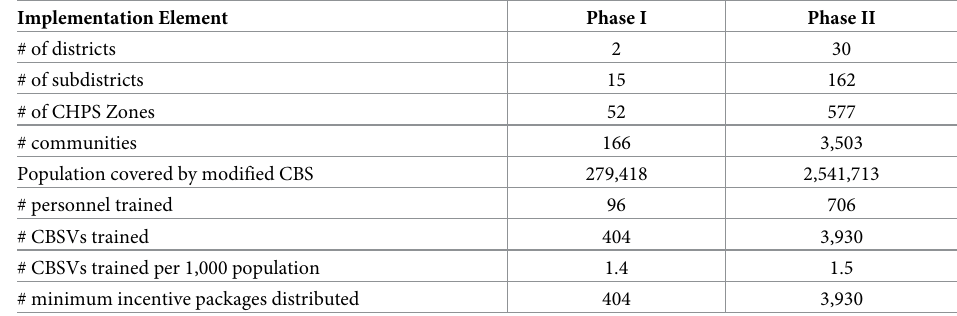
Table 1. Implementation elements of modified CBS in Phase I and Phase II.